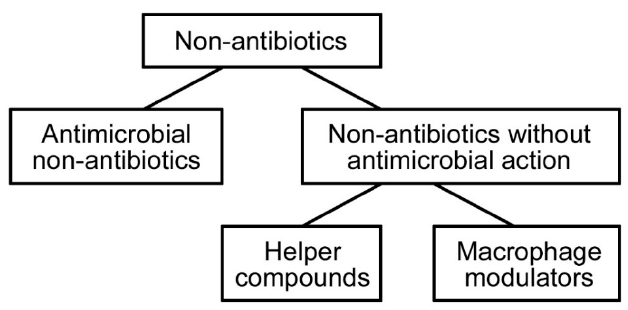
Figure 4. Scheme of the division of non-antibiotics.